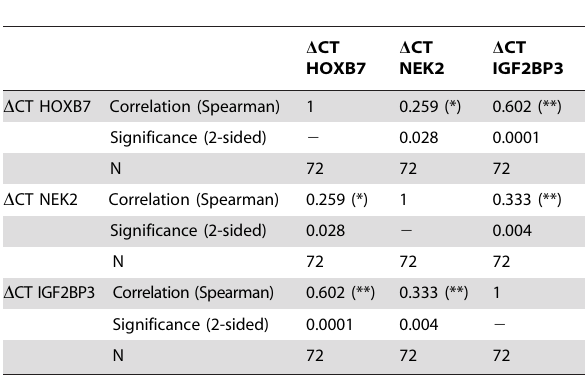
Table 2. Correlation between candidate gene D CT levels in patients with malignant strictures.